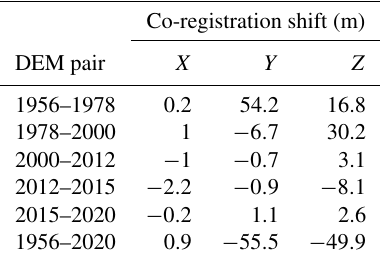
Table 2. Linear co-registration shifts calculated over stable terrain between the respective DEM